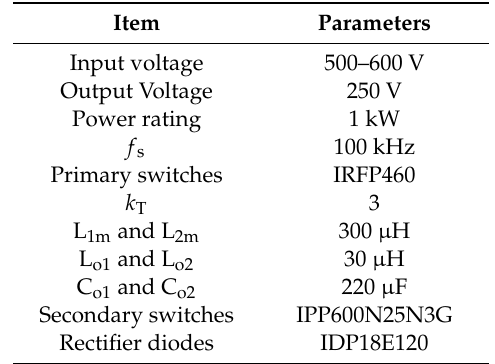
Table 9. Parameters of the